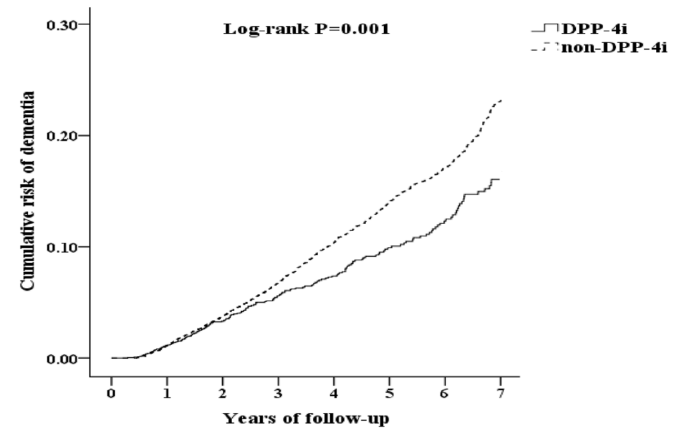
Figure 2. Kaplan–Meier curves for the cumulative risk of dementia in diabetic patients with or without dipeptidyl peptidase 4 inhibitor use. Table 1. Baseline characteristics of the matched pairs.